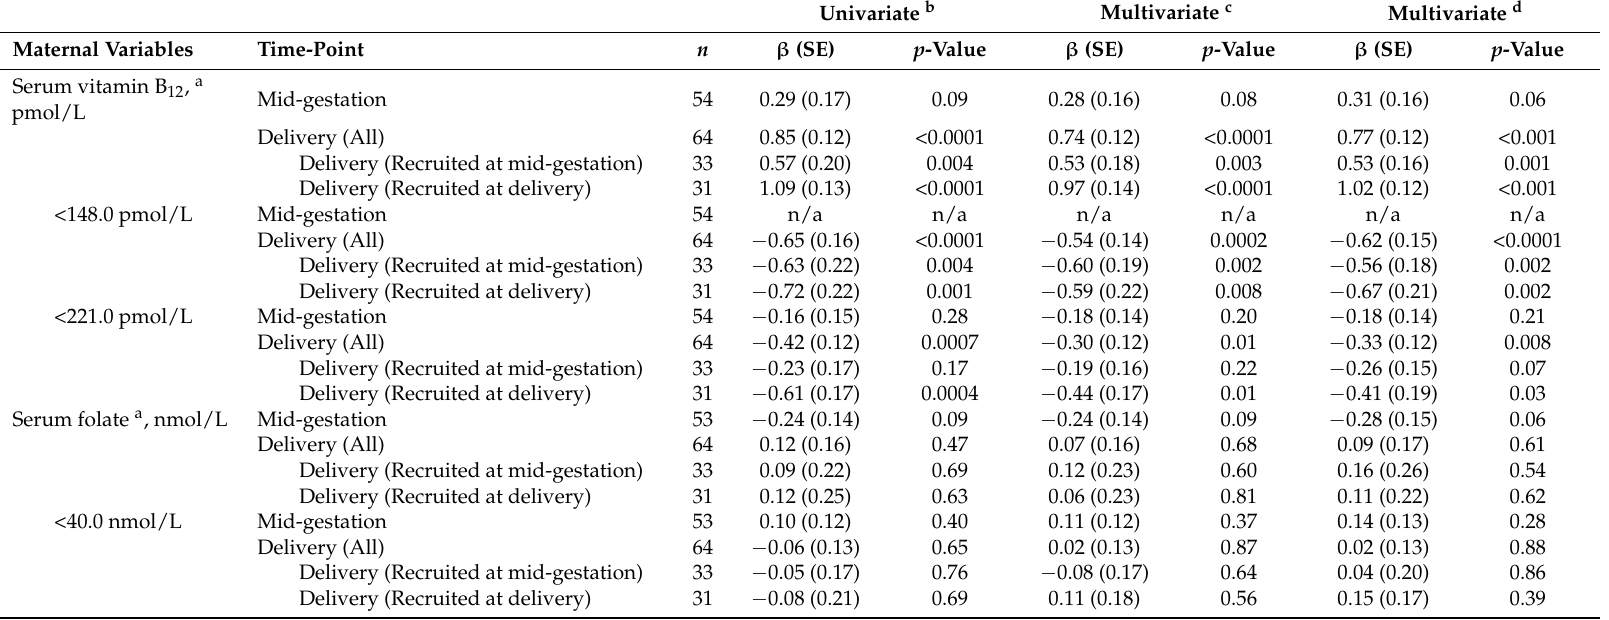
a Statistical analyses: Linear regression models were used to examine associations between maternal vitamin B 12 and folate status and infant serum vitamin B 12 concentrations; vitamin B 12 and folate concentrations were natural logarithmically transformed prior to analyses; b Adjusted for gestational age of sample collection; c Adjusted for gestational age of sample collection, maternal age at delivery, parity ( ≥ 1 vs. 0), ever smoked (yes vs. no), relationship status (single vs. married/in a relationship), self-reported prenatal supplement use ( ≥ 2 vs. <2 pills/week), pre-pregnancy BMI, and race (African American vs. other); d Adjusted for gestational age of sample collection, maternal age at delivery, parity ( ≥ 1 vs. 0), ever smoked (yes vs. no), relationship status (single vs. married/in a relationship), self-reported prenatal supplement use ( ≥ 2 vs. <2 pills/week), pre-pregnancy BMI, race (African American vs. other), intake of vitamin B 12 , and intake of